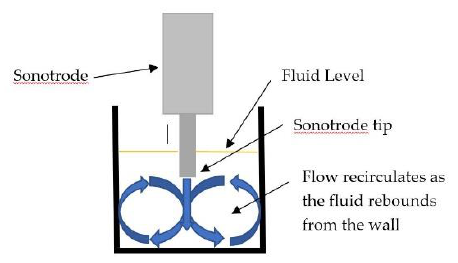
Figure 4. Sketch simulating the velocity field produced in a liquid that is subject to ultrasonication